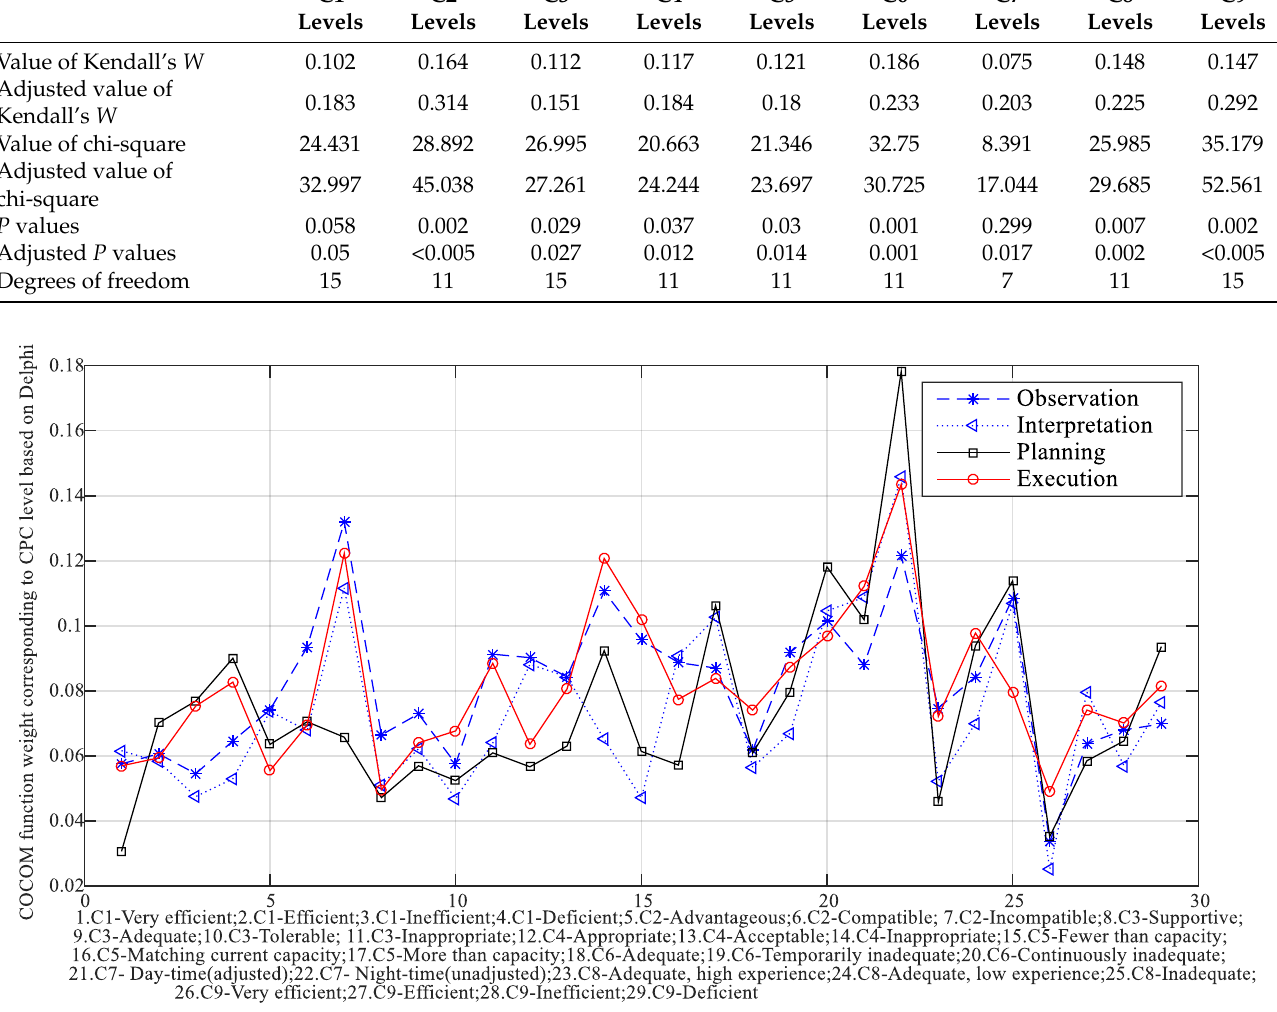
Figure 7. COCOM function weight corresponding to the different CPC levels based on the Delphi method.